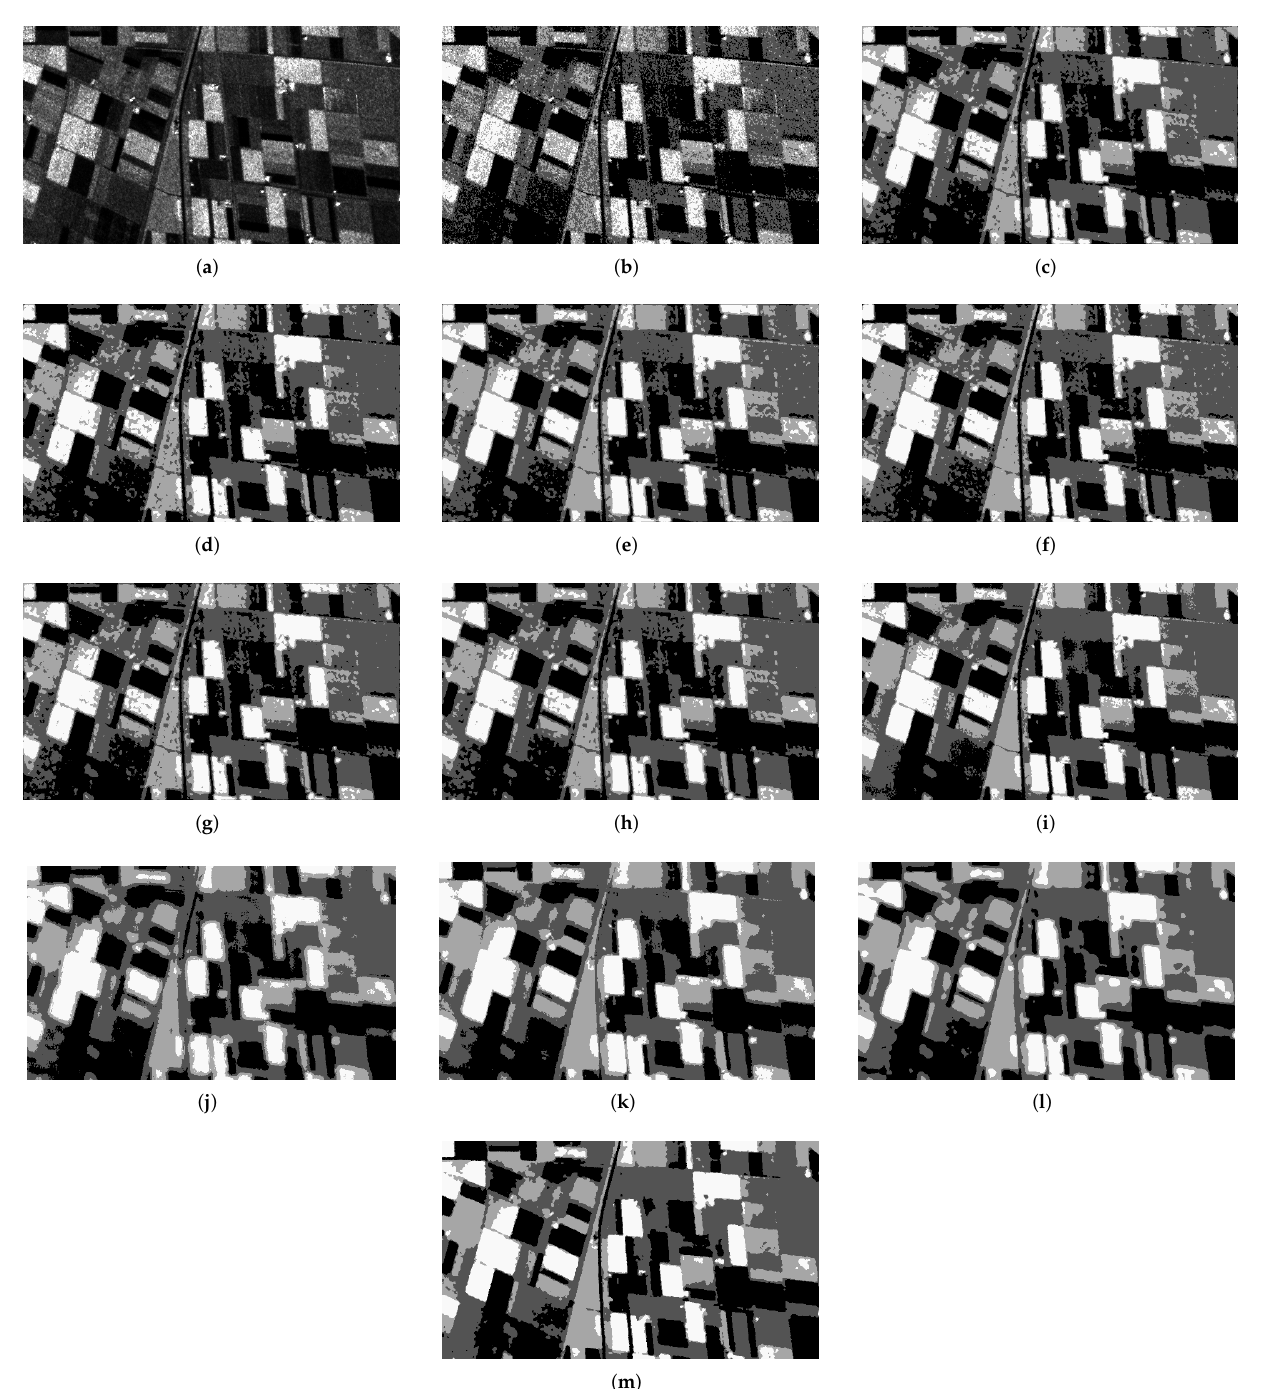
Figure 13. The segmentation results of each algorithms on the real SAR image. ( a ) Original image. ( b ) FCM. ( c ) FCM_S1. ( d ) FCM_S2. ( e ) KFCM_S1. ( f ) KFCM_S2. ( g ) EnFCM. ( h )